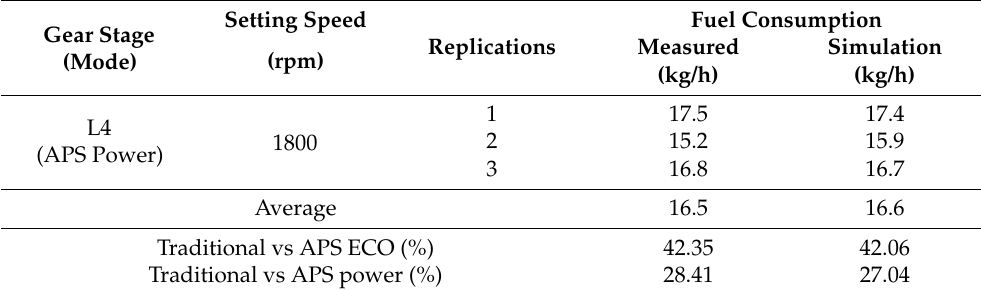
Table 7. Fuel consumption analysis during rotary tillage. Table 7. Cont.